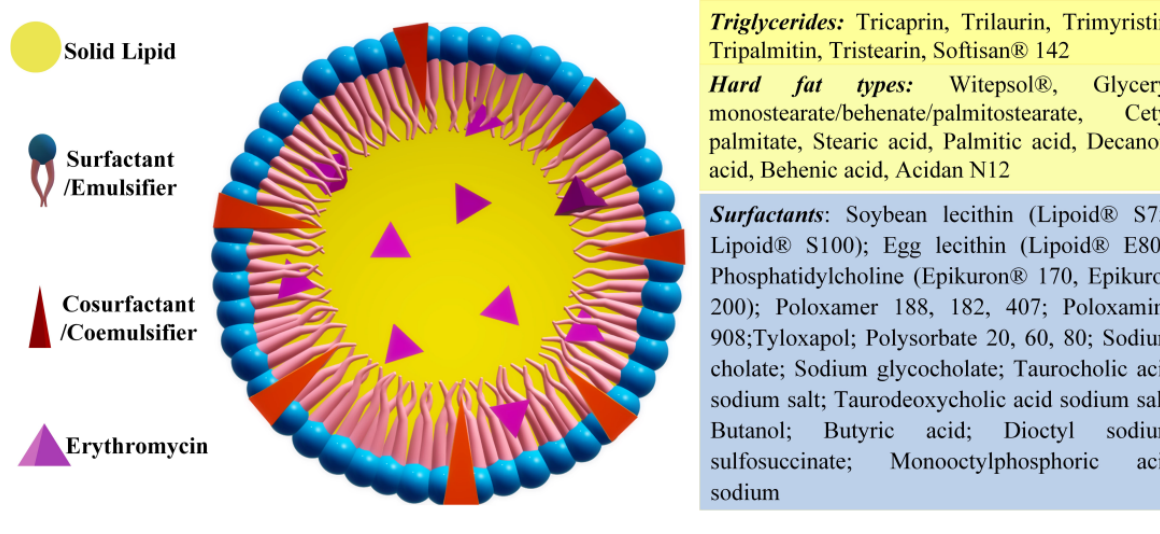
Figure 9 . Schematic representation of an ERY solid lipid nanoparticle. Figure 9. Schematic representation of an ERY solid lipid